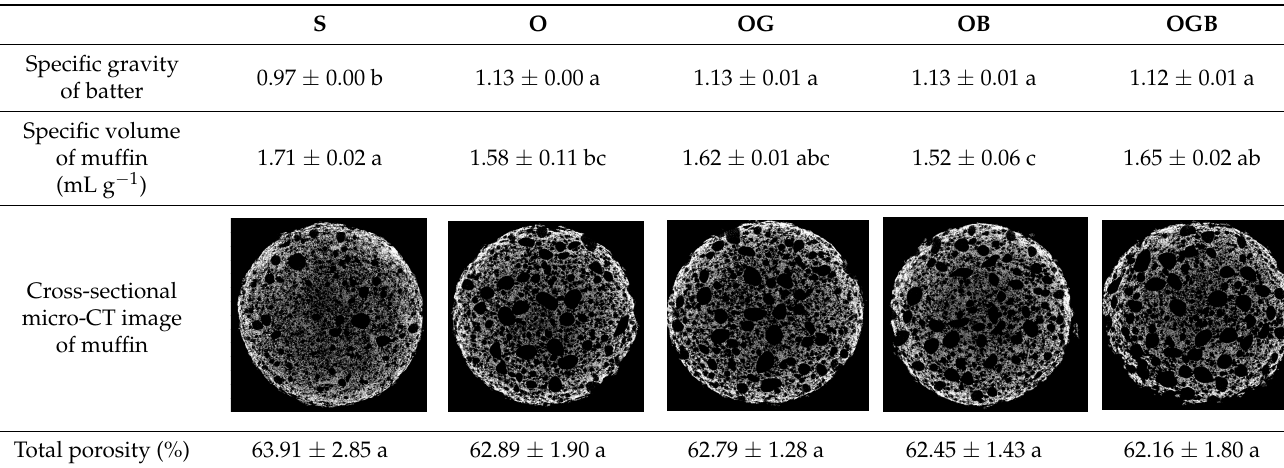
Samples were named oleogel (O), oleogel with GMS (OG), oleogel with β -carotene (OB), and oleogel with GMS and β - differ significantly by Duncan test ( p < 0.05). differ significantly by Duncan test ( p < 0.05).